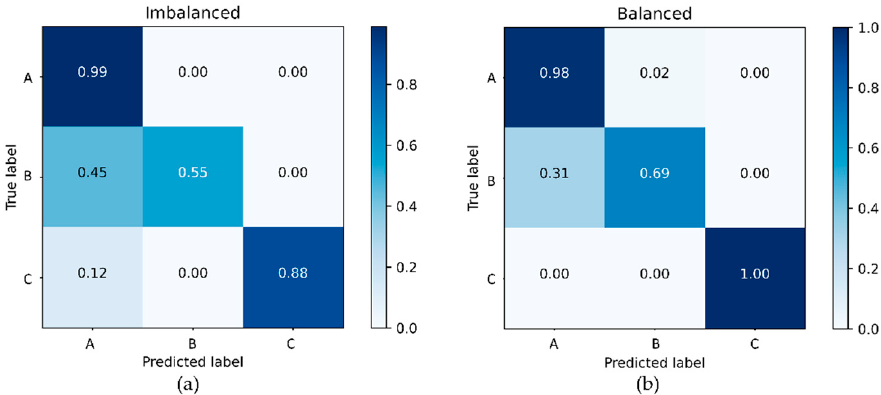
Figure 15. Confusion matrices for road anomaly monitoring with the base classifier trained on ( a ) the original (imbalanced) set and ( b ) the original data augmented with the Unrolled GAN.